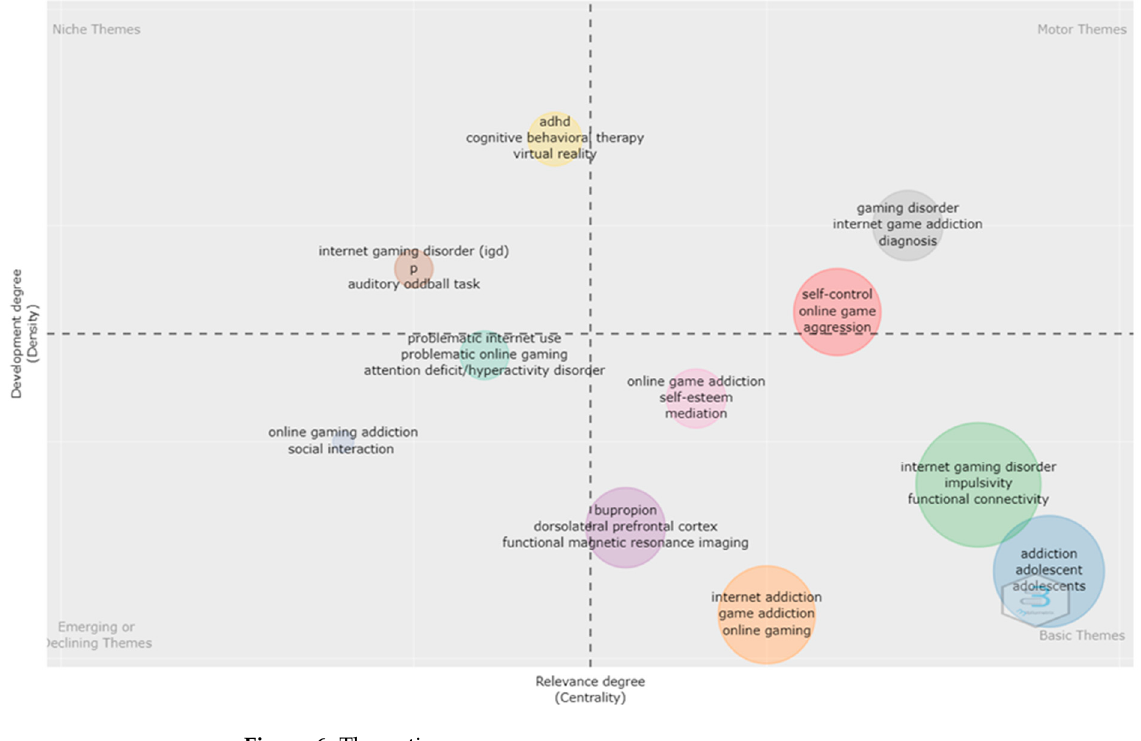
Figure 6. Thematic map.